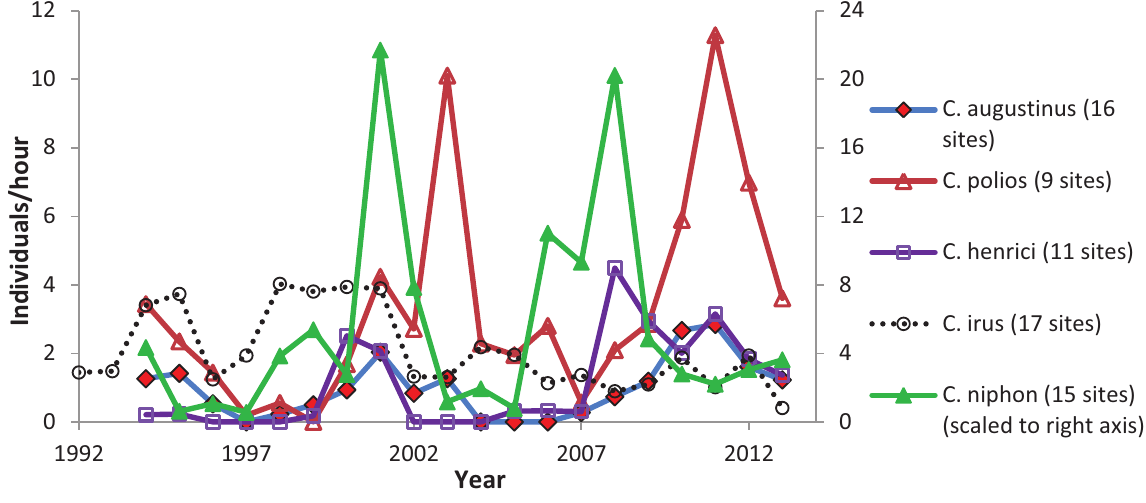
Figure 3. Mean abundance on peak count per year at the study sites in central Wisconsin, by species.